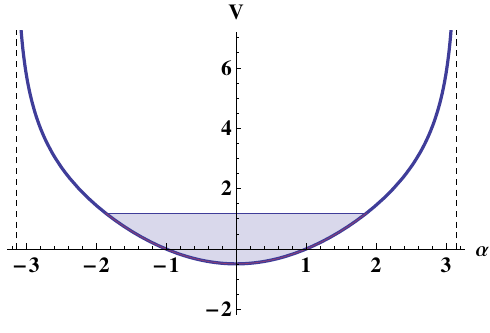
Figure 3 . Potential in region I (here (cid:21) = 4, (cid:28) =